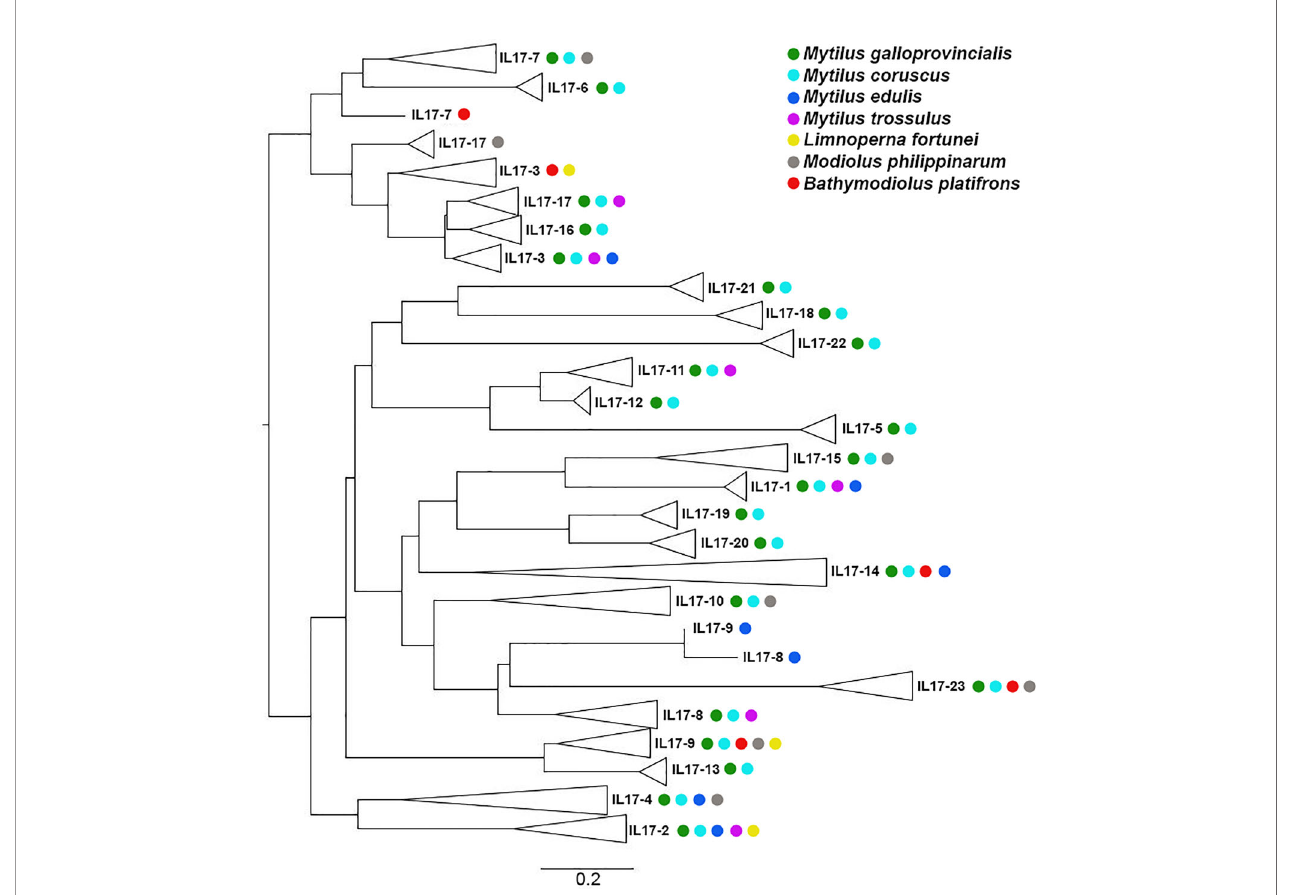
FIGURE 3 | Phylogenetic analysis of the IL-17 families found in Mytilidae species. Homologous sequences to the M. galloprovincialis IL-17 isoforms were found in several Mytilidae species and submitted to neighbor joining analysis using the Jukes – Cantor substitution model. Clustering was based on isoform homologs, and species are indicated with